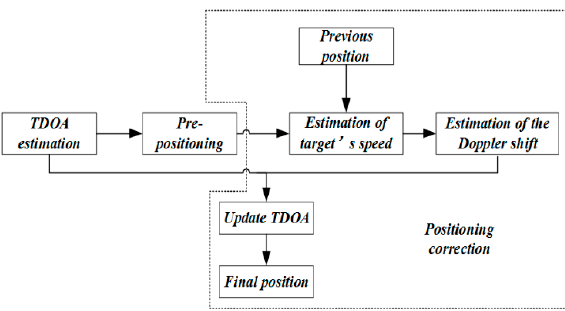
Figure 5. Basic idea of the shrinking-circle (SC) method.